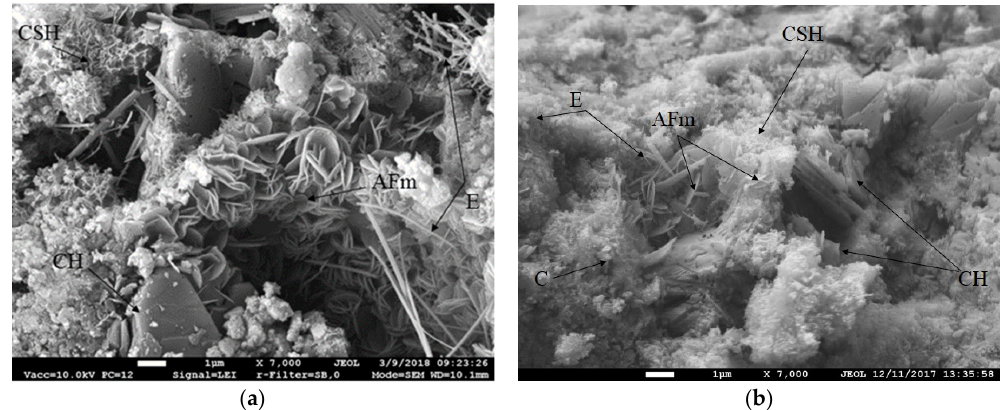
Figure 12. Microstructure images of ( a ) specimen without TS, and ( b ) specimen with 6% of sand replaced with TS (magnification: ×7000).